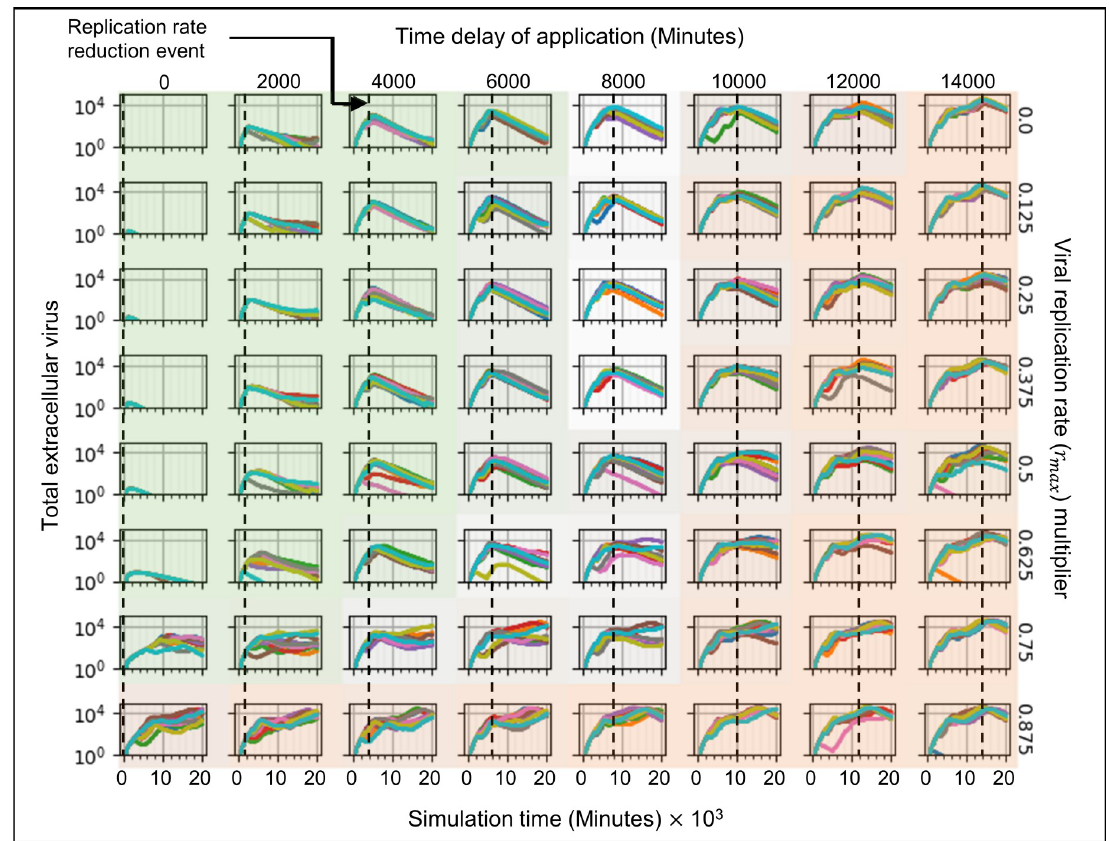
Fig 10. Levels of extracellular virus vs time in simulations of a hypothetical drug treatment reducing the viral genome (e.g. RNA for SARS-CoV-2) replication rate ( r max ) as a function of drug potency (one minus the viral replication rate multiplier) and time of initiation of treatment. Extracellular virus is cleared or near-cleared when intervention occurs soon after infection. Parameter values, axis types and time-scale and shading as in Fig